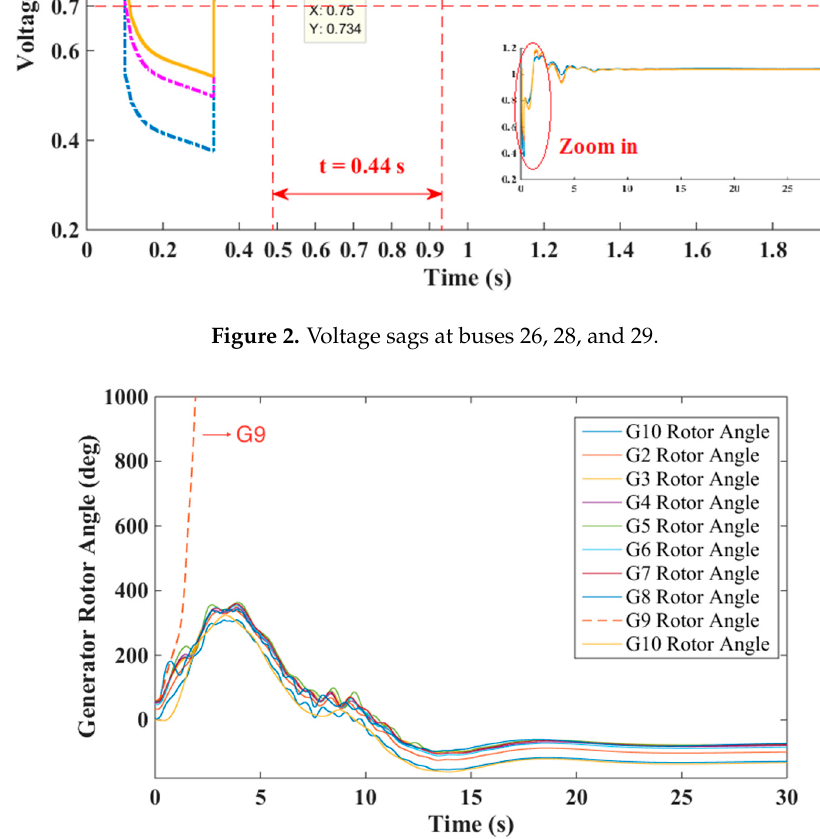
Figure 3. System separation between G9 and others.